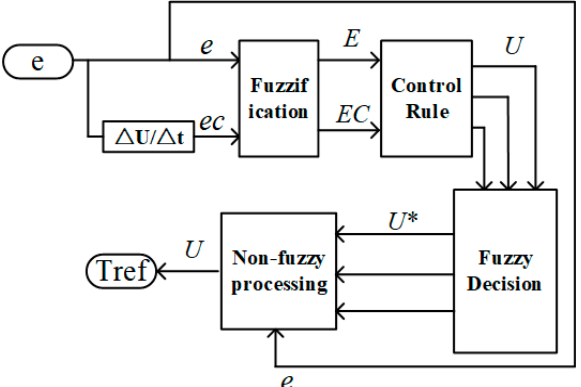
Figure 4. Fuzzy PID control structure diagram.